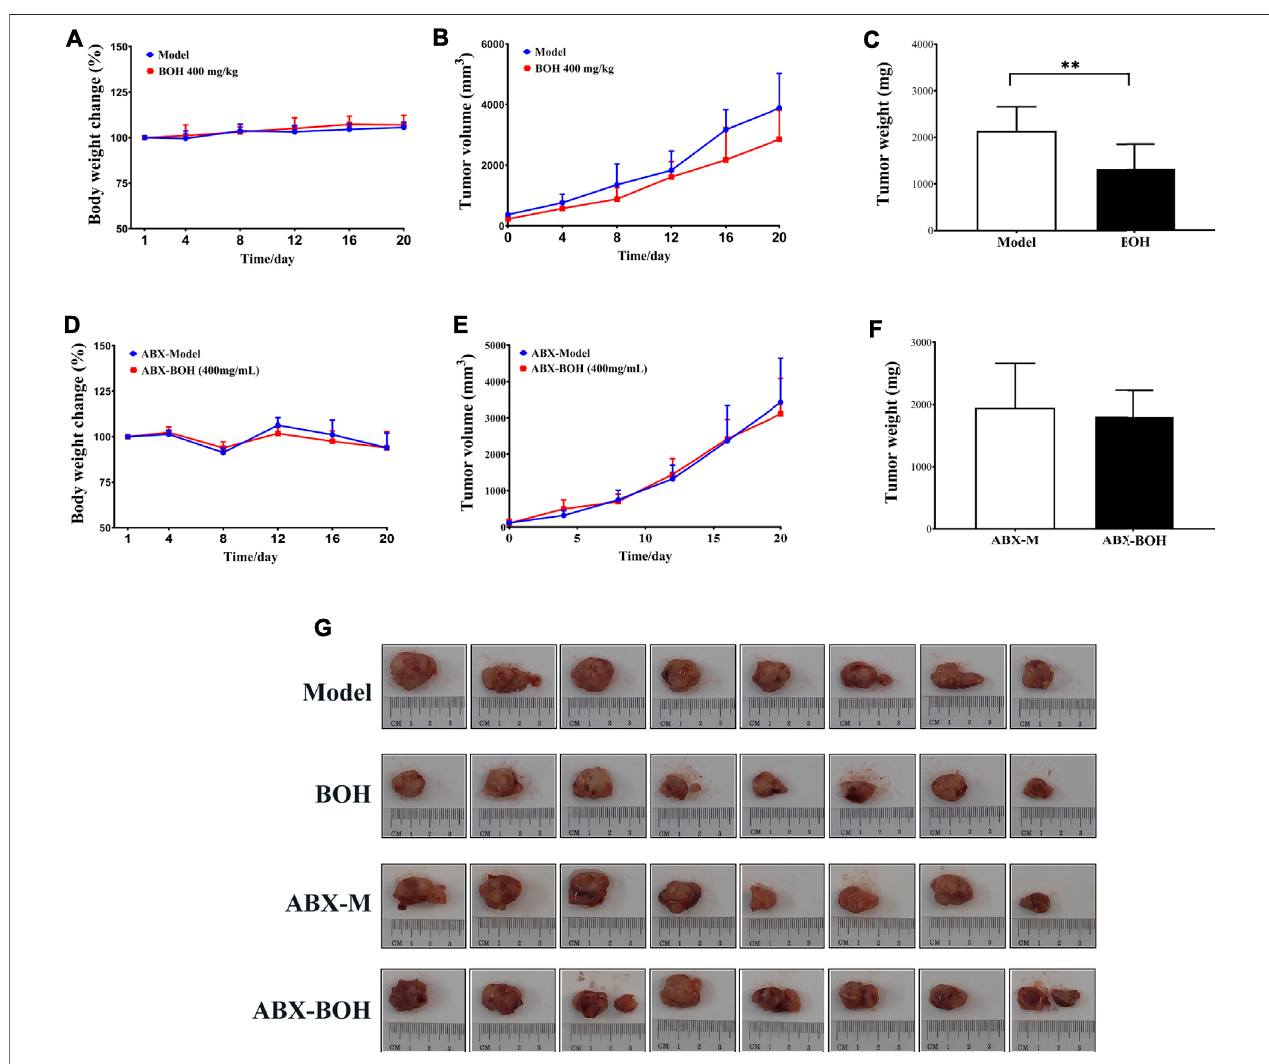
FIGURE 4 | BO suppresses MDA-MB-231 tumor growth under SPF condition but failed under PSF condition. (A – C) Tumor volume and tumor weight under SPF condition. (D – F) Tumor volume and tumor weight under PGF condition. (G) Tumor pictures. n (cid:2) 8. * p < 0.05 and ** p < 0.01.